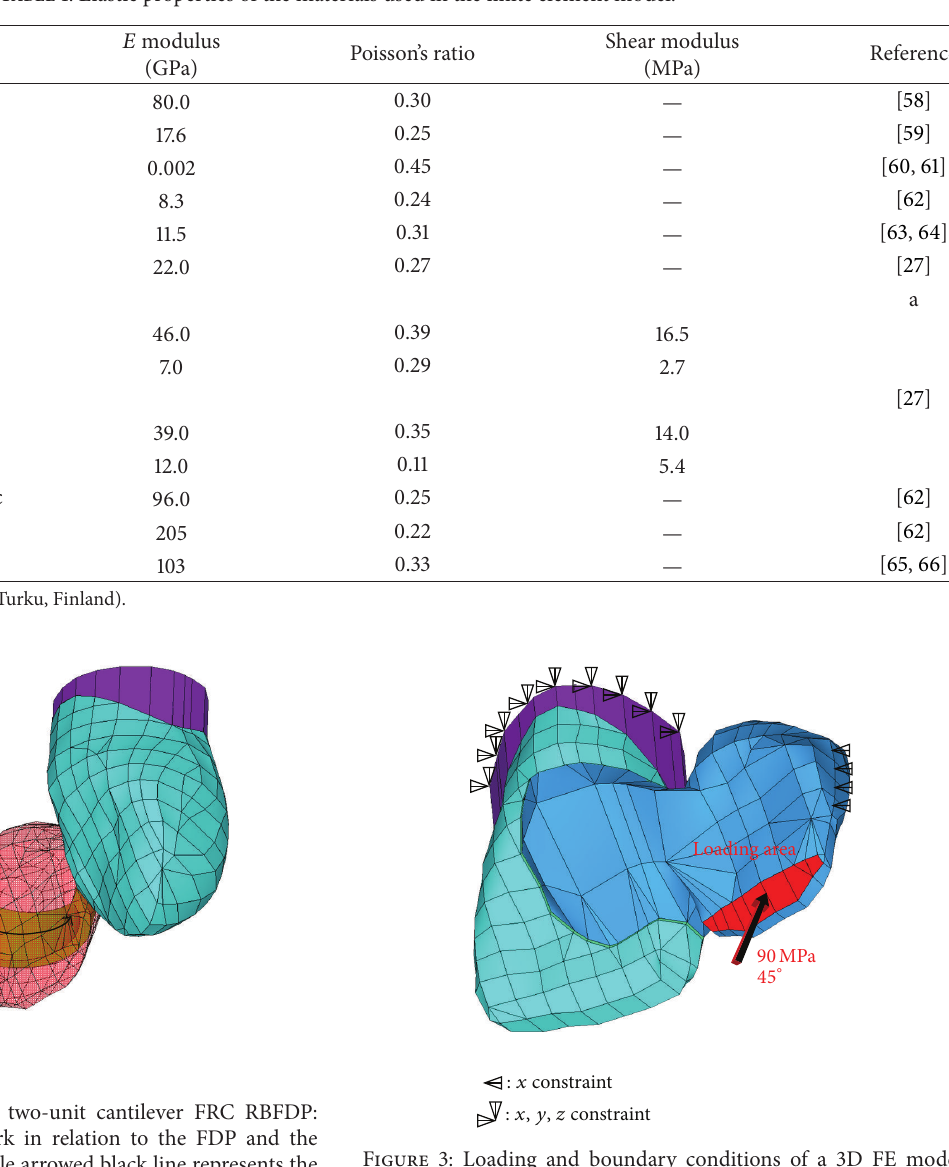
Table 1: Elastic properties of the materials used in the finite element model.